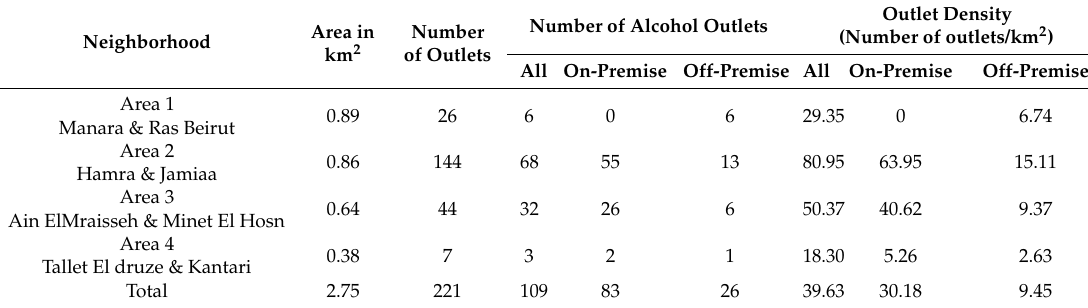
Table 2. Number and density of alcohol outlets by area